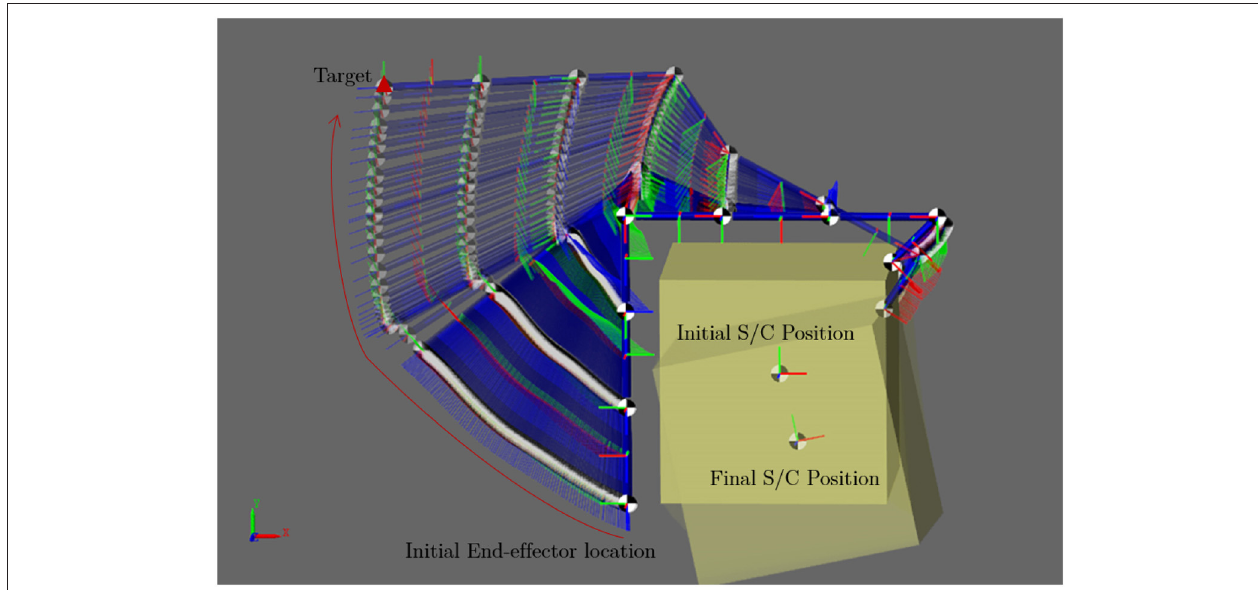
FIGURE 13 | Motion trajectory sampled from learned probabilistic distribution to minimize the rotation of the free-floating spacecraft.